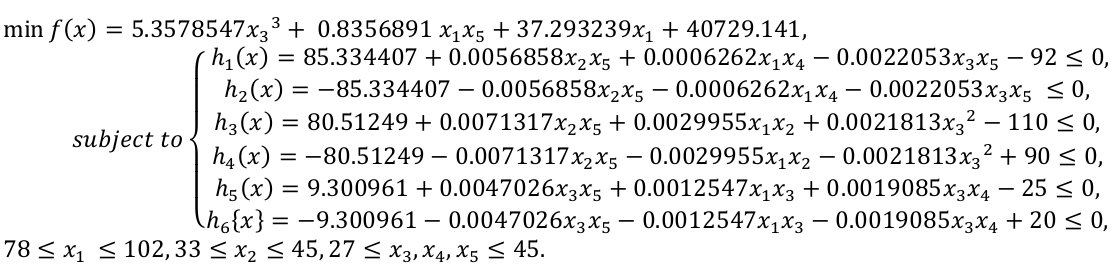
Table 13. Reported results for constrained problem 7 from different optimizers